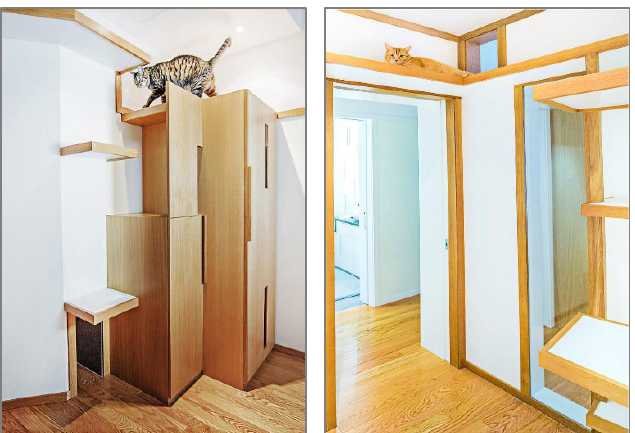
Figure 15 Small living space furniture and wall details designed by “viaARCHITECTS” (URL-9)